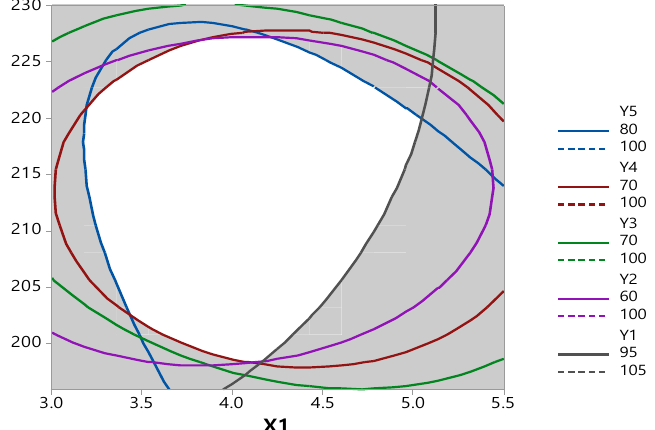
Figure 4. Nesting contour plot of dependent variables versus independent variables for all re- sponses.